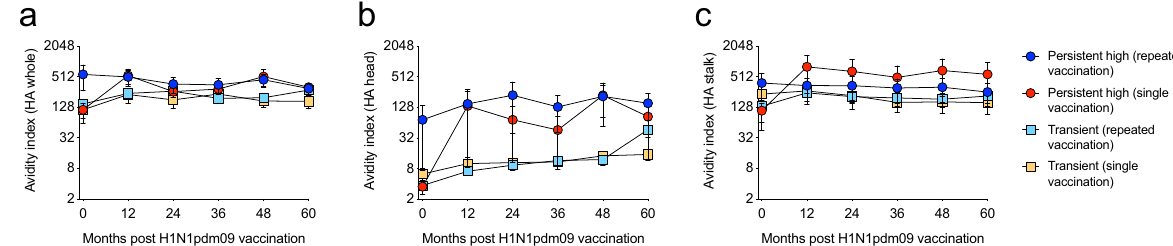
Fig. 4 Trend of higher avidity in persistent high responders. The IgG avidity to the HA protein of the H1N1pdm09 virus before each in fl uenza season were measured by the avidity ELISA assay against three different domains of the HA protein: whole HA ( a ), HA head ( b ) and HA stalk ( c ). Persistent high responders are shown as circles and transient responders as squares. Repeated vaccination is shown in blue and turquoise, and single vaccination is shown in red and orange. The means and standard errors of the means are